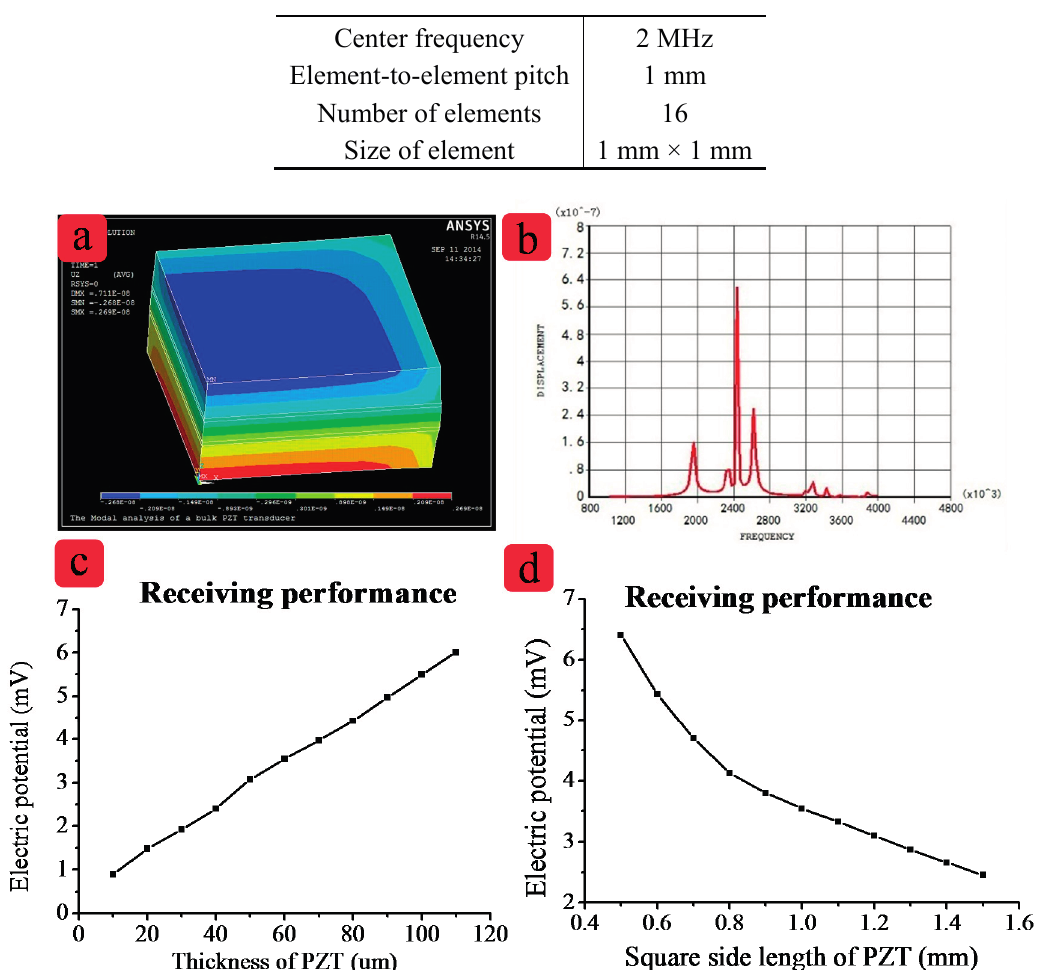
Figure 2. ( a ) the displacement along the Z axis. The red means the positive displacement and the blue means the negative displacement; ( b ) shows the resonant frequency of the simulation; ( c ) and ( d ) show the thickness and the size which are influence the frequency of the